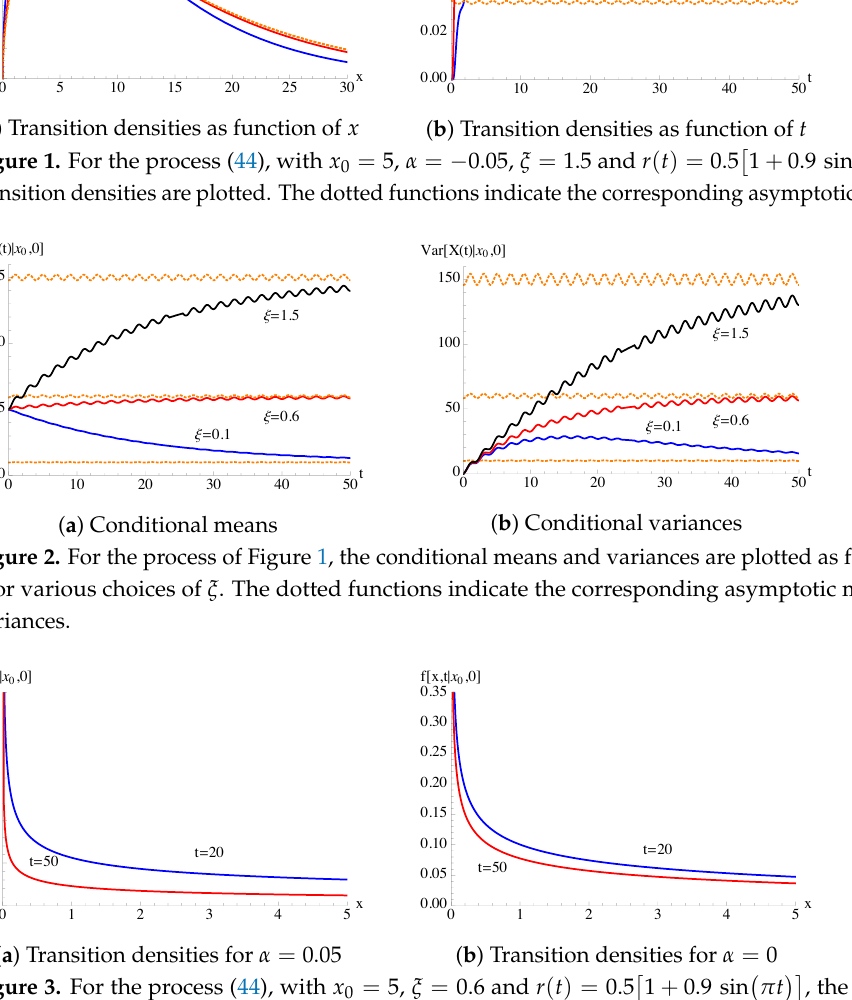
(cid:2) (cid:0) (cid:1)(cid:3) π t 1 + 0.9 sin , the transition